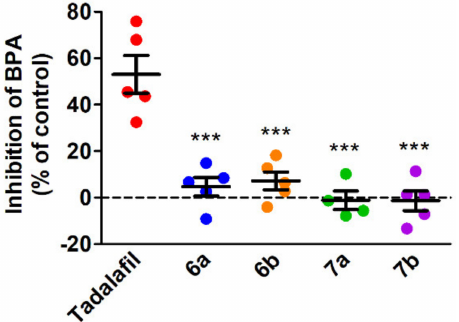
Figure 12. Inhibition of blood platelet aggregation (BPA) by tadalafil and its analogues in the presence of DEA-NO evaluated by light transmittance aggregometry. Platelet rich plasma was preincubated for 5 min with tadalafil (10 µ M) or its analogues, 6a,b , 7a,b (10 µ M). Shortly prior to measurement, 500 nM DEA-NO was added, followed by 2 µ g/mL collagen. Percentage of inhibition of platelet response was calculated in comparison to a sample treated with DMSO and DEA-NO on the basis of maximal value of platelet aggregation. Black horizontal lines on data points show means and standard deviations. Statistical analysis was performed via one-way analysis of variance with Tukey’s multiple-comparison test (***, p <